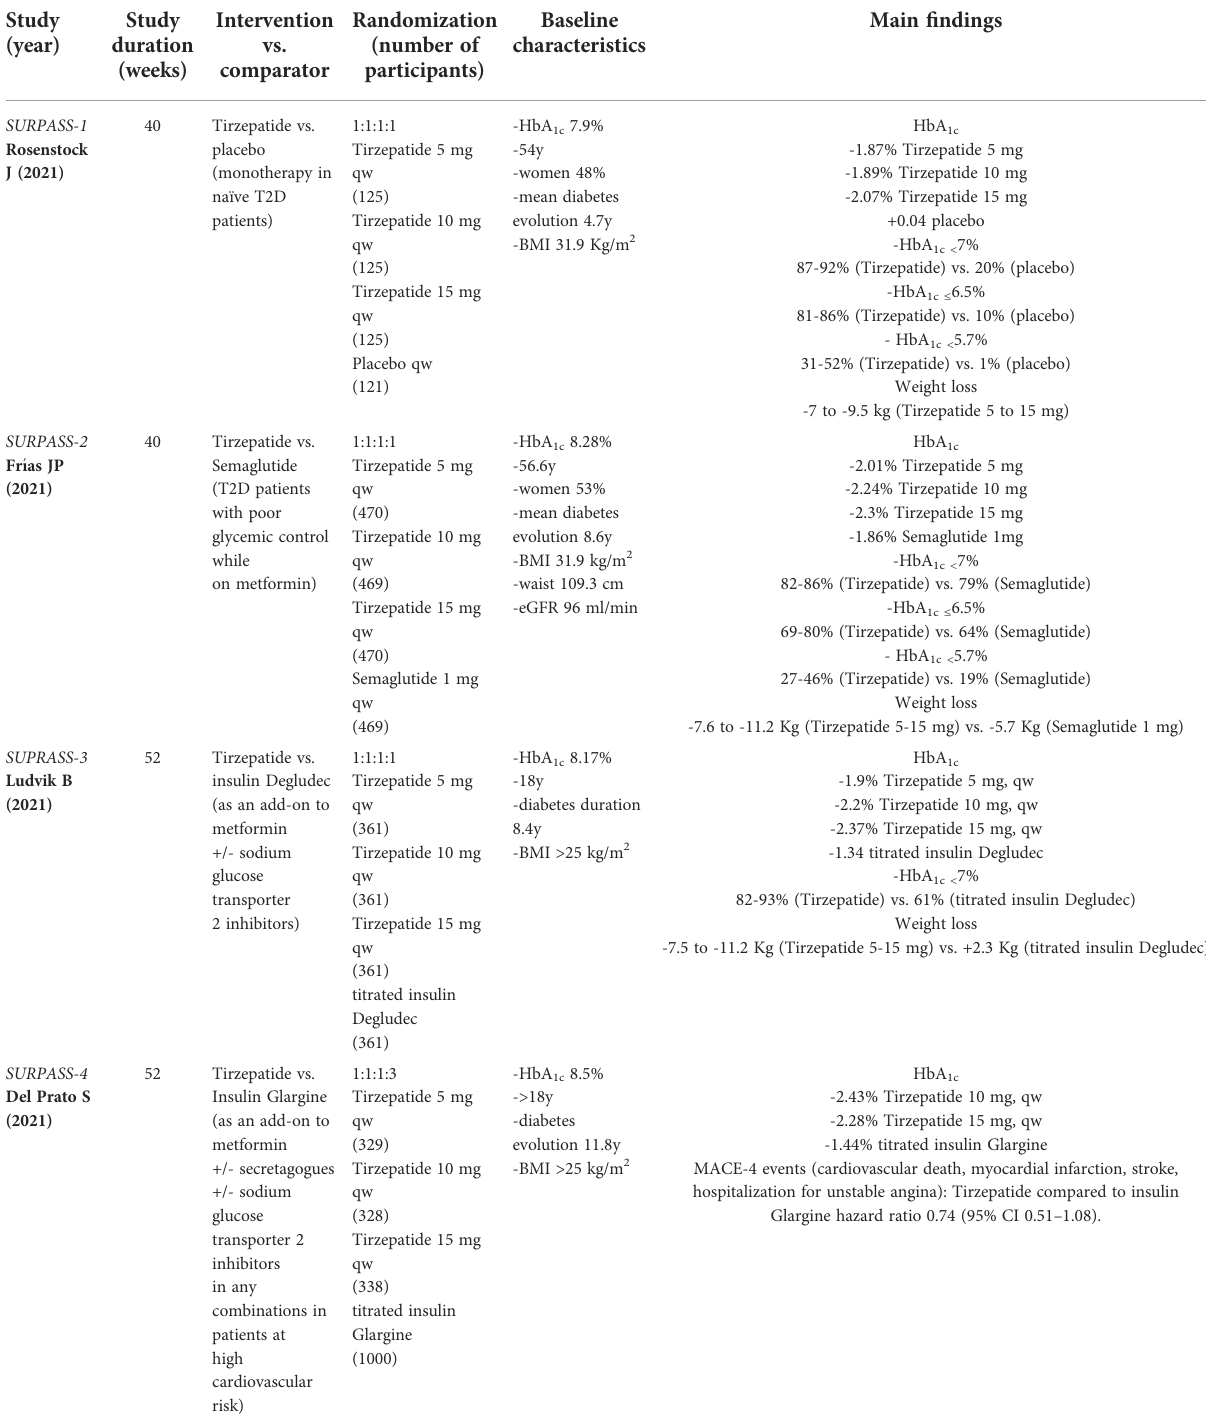
TABLE 1 Summary of the SURPASS program, phase III clinical trials (34 –